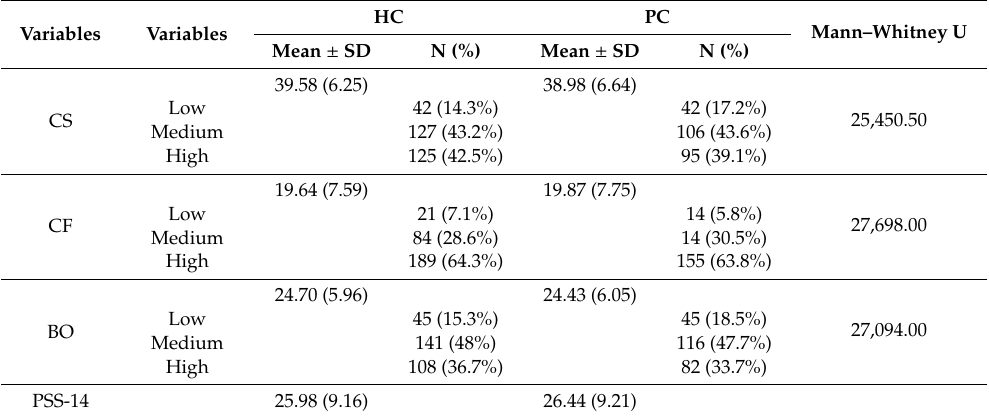
Table 2. Professional quality of life and perceived stress: hospital care and primary